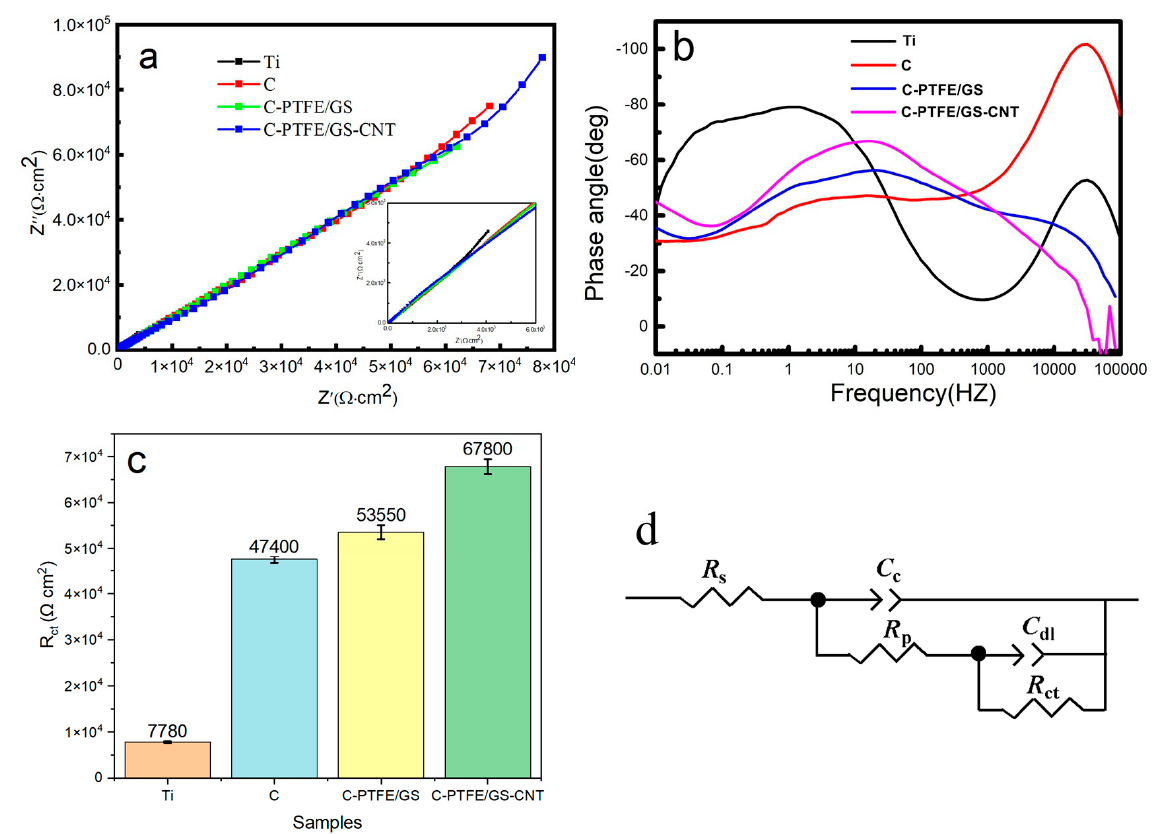
Figure 7. EIS curves of bare Ti, carbon and carbon − PTFE, carbon-PTFE/GO and carbon-PTFE/GO- CNT composite films.( a ) Nyquist plots; ( b ) Bode plots; ( c ) R ct value; ( d ) Equivalent circuits.